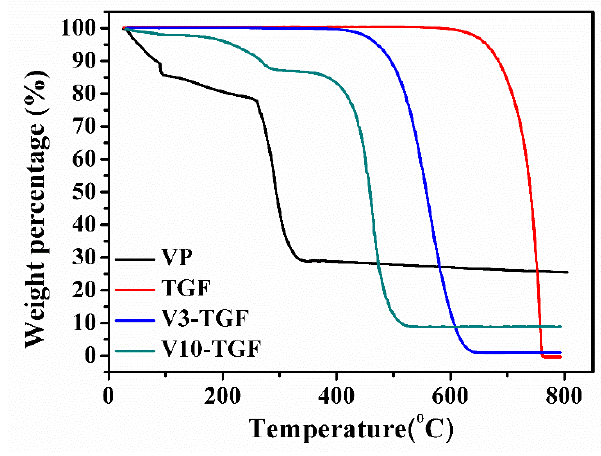
Figure 1. TGA profile of VP and graphite felt electrodes.